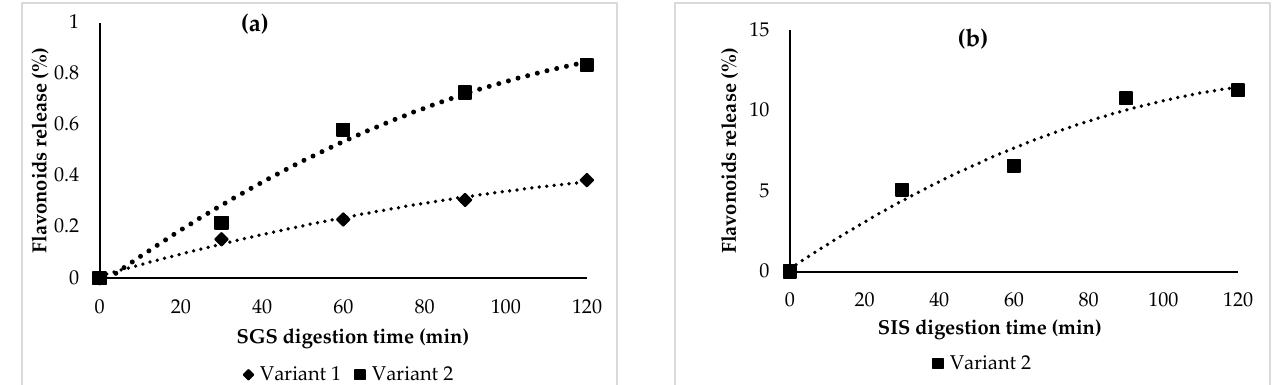
Figure 2. Flavonoid release (%) after in vitro digestion in the simulated gastric ( a ) and intestinal juices ( b ).